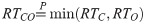
The observed and predicted distributions of reaction times for a double- or triple-feature singleton, using four different race models (race equalities), RTCO=Pmin(RTC,RTO) (in panel A), RTMO=Pmin(RTM,RTO) (in panel B), RTCM=Pmin(RTC,RTM) (in panel C), or RTCMO=Pmin(RTC,RTM,RTO) (in panel D), in a race between the corresponding racers whose reaction times are those of the corresponding single-feature singletons.The data are from the same subject SA already shown in Fig 3, panel A shows the same information as that in the bottom panel of Fig 3. The predicted and observed distributions are significantly different from each other except in panel C.